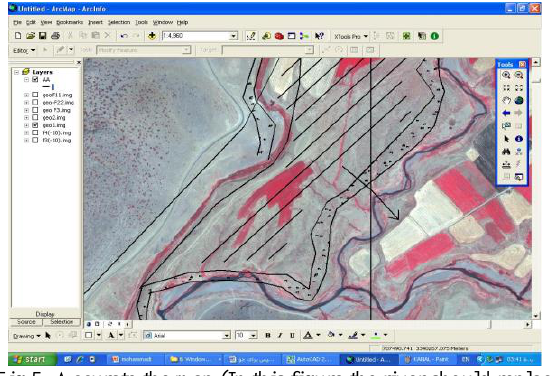
Fig 5- Accurate the map (In this figure the river should replace in its correct place)